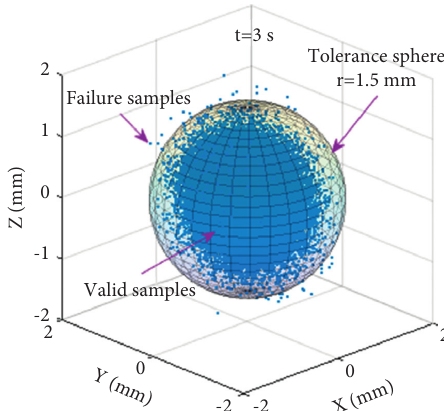
Figure 6: Position of random points.